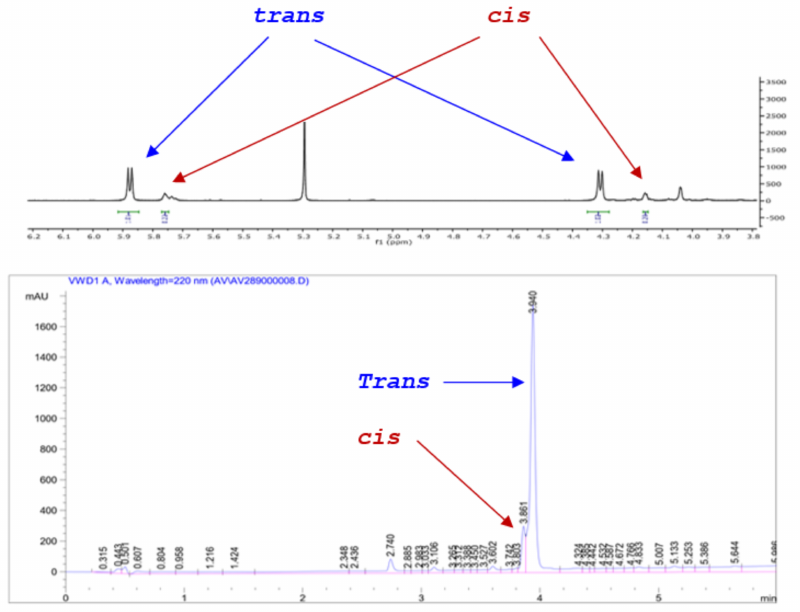
Scheme 6. HPLC and 1 H NMR of crude product 13 demonstrating consistent assessment of cis/trans isomer